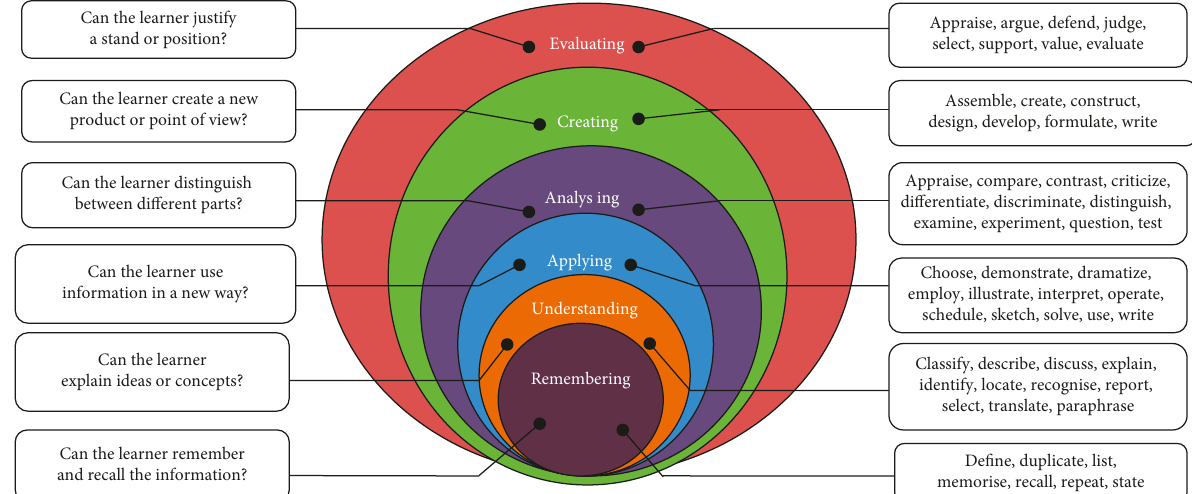
Figure 6: The revised Bloom’s taxonomy for educational learning.